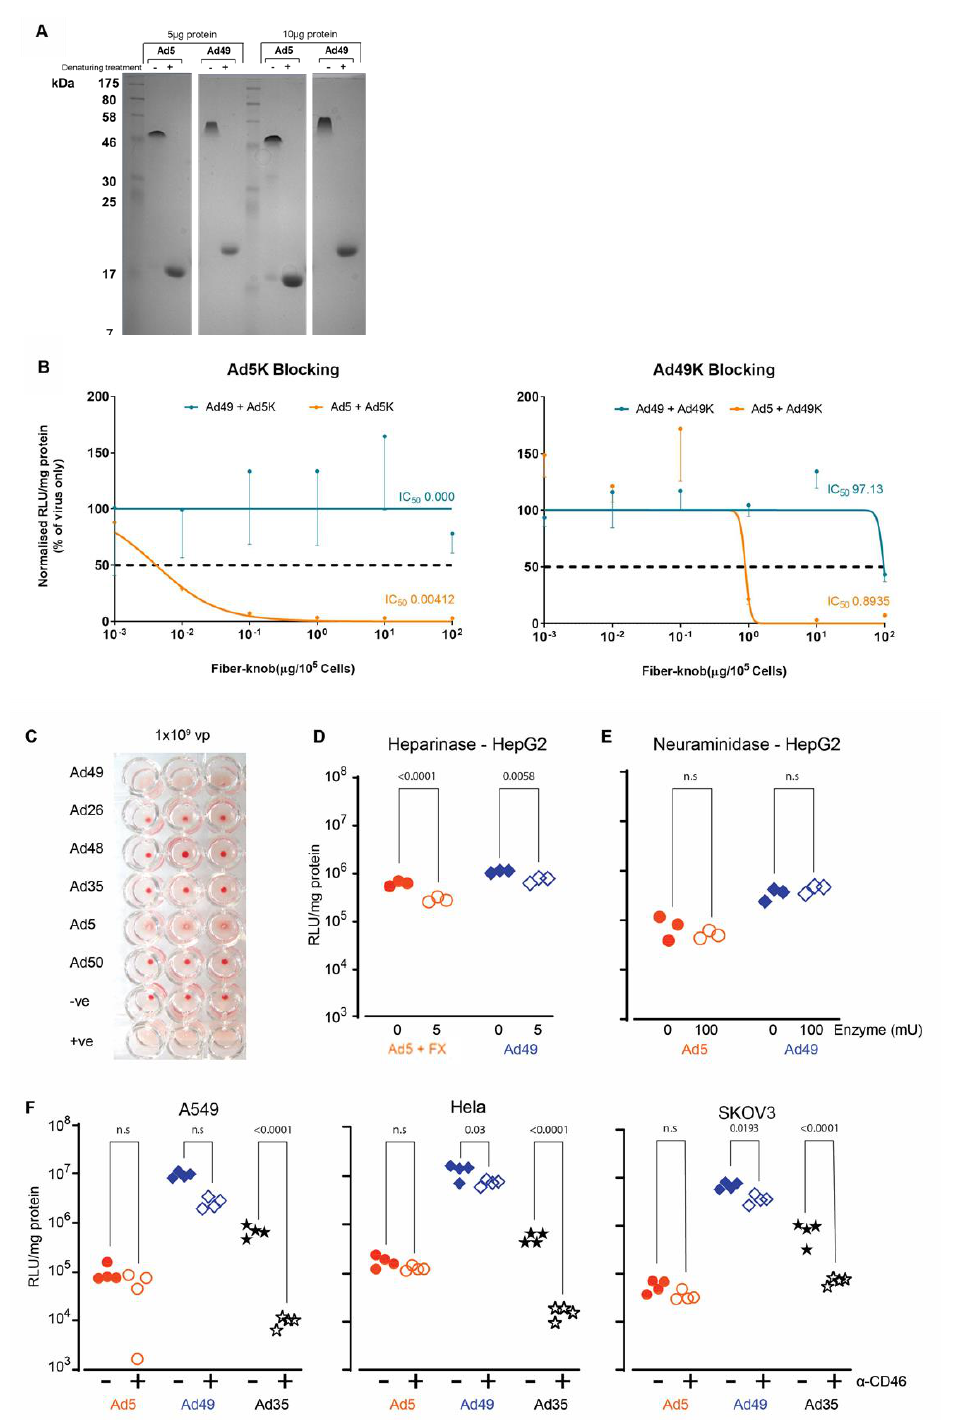
Figure 5. HAdV-D49 can interact with multiple receptors to transduce target cells. ( A ) Recombinant HAdV-C5K and HAdV-D49K with or without treatment using a denaturing agent were stained with Coomassie. ( B ) Blocking of HAdV-C5 (Ad5) and HAdV-D49 (Ad49) transduction in hepatocytes (HepG2) with dilution of HAdV-C5 or HAdV-D49 fibre knob (100–0.001 µg/10 5 cells). ( C ) Haemagglutination profiling of several adenovirus serotypes, including HAdV-C5 and HAdV-D49. Negative (-ve, PBS) and positive (+ve, PBS containing 0.2% Tween-20) were also used as relevant controls; three wells are shown reflecting technical replicates. ( D ) HAdV-C5 + FX and HAdV-D49 transduction in HepG2 cells after treatment with heparinase. ( E ) HAdV-C5 (shown as Ad5) and HAdV-D49 transduction in HepG2 cells after treatment with neuraminidase. ( F ) Transduction of HAdV-C5, HAdV-D49, and HAdV-B35 (Ad35) in A549, HeLa, and SKOV3 cells following blocking with 258-MEM, anti-CD46 antibody. n.s; not statistically significant, p >